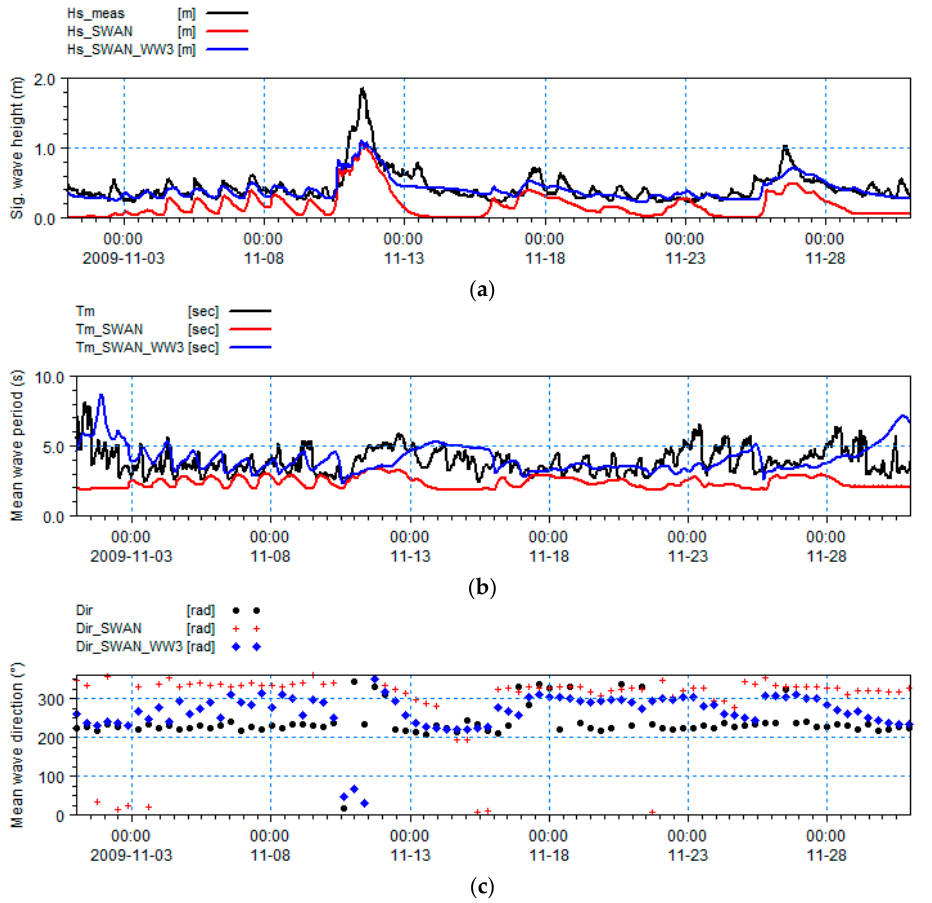
Figure 7. Comparison of Simulating Waves Nearshore (SWAN) wave model results with buoy data (without vegetation). ( a ) Significant wave height ( b ) Mean wave period ( c ) Mean wave direction.